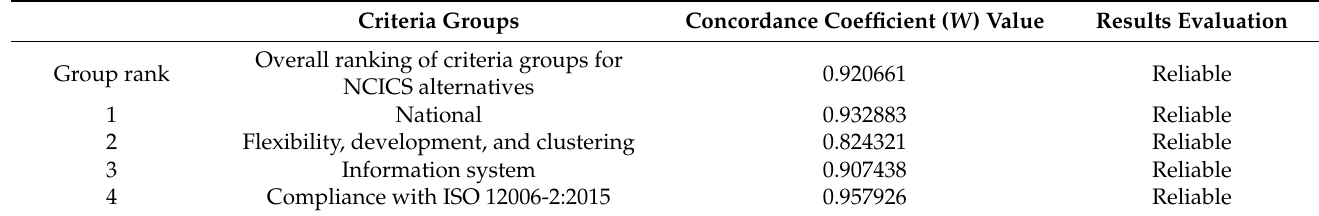
Table 6. Ranking of criteria groups and values of Kendall’s concordance coefficient.